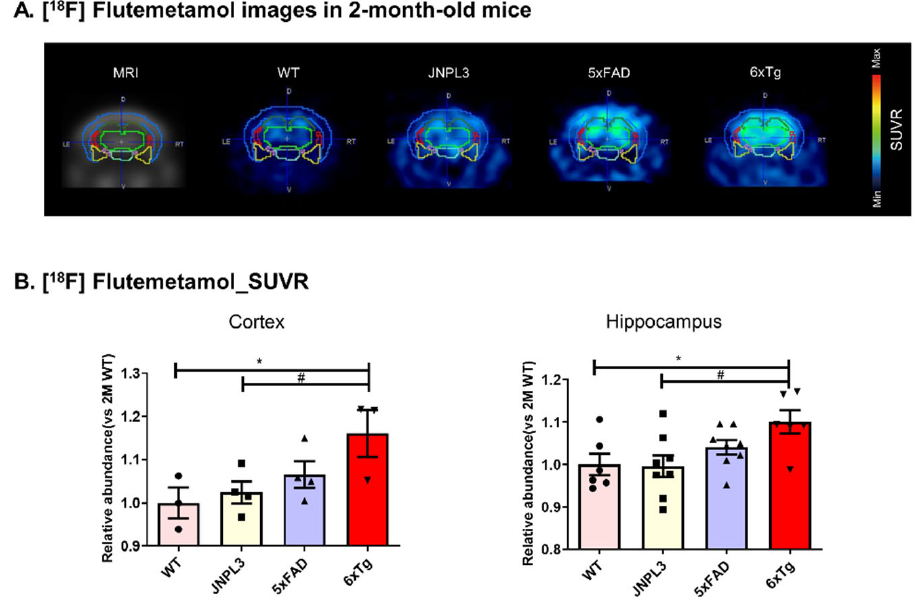
Figure 1. [ 18 F]Flutemetamol uptake in the cortex and hippocampus of 2-month-old 6 × Tg mice brains by in vivo microPET analysis. ( A ) MicroPET images of [ 18 F]Flutemetamol radiotracer in the brain. Coronal microPET images summed over 50–60 min after [ 18 F]Flutemetamol injection are shown for WT, JNPL3, 5 × FAD, and 6 × Tg mice. ( B ) ROI-to-cerebellum ratios (ROI = cortex or hippocampus) from [ 18 F]Flutemetamol data measured over 50–60 min were calculated for 2-month-old WT, JNPL3, 5 × FAD, and 6 × Tg mice. Increased [ 18 F]Flutemetamol retention is detected in the cerebral cortex and hippocampus of 6 × Tg mice compared with that in WT or JNPL3 mice, but signals in 6 × Tg mice exhibit no significant difference compared with that in 5 × FAD mice. All data are presented as the mean ± SEM (n = 3–4 mice per group). Statistical analyses are performed using one-way ANOVA, followed by Fisher’s exact test. * p < 0.05 vs. WT, # p < 0.05 vs. JNPL3.